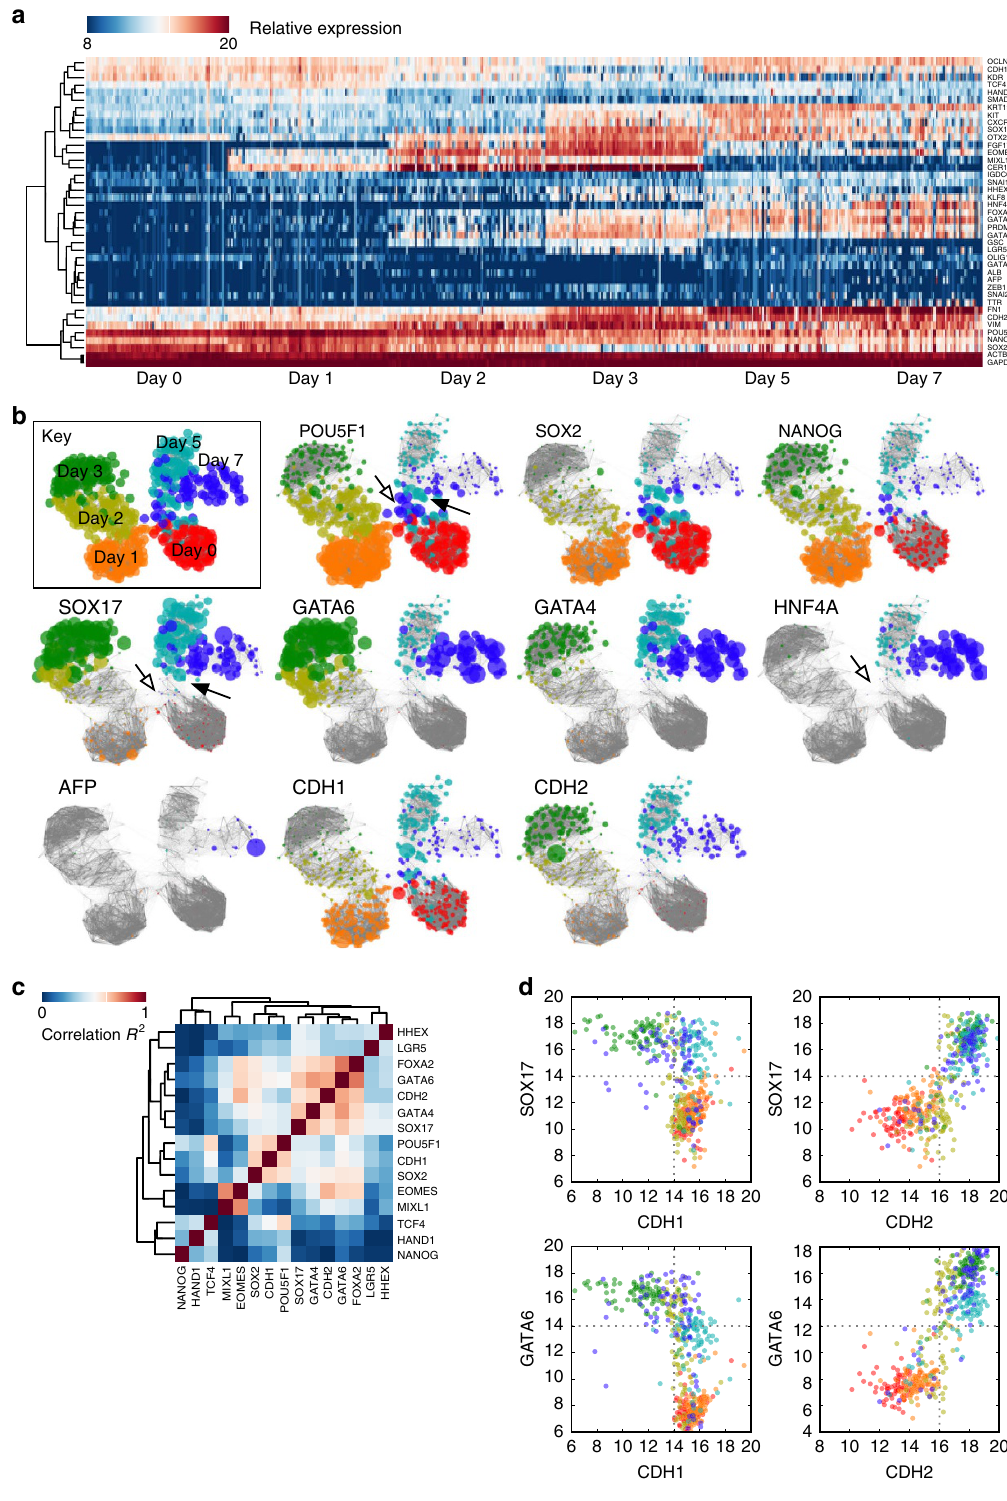
Figure 3 | Single cell qPCR analysis reveals a synchronous EMTduring the differentiation of hESCs to DE. ( a ) Heatmap of the expressions of selected genes. A complete list of genes used in the study can be found at Supplementary Table 3. ( b ) Relational network plots. Different colours indicate specific days of treatment, node sizes are 2 (relative expression) . Open arrows indicate a population of day 5/7 hESC-like cells expressing POU5F1 , SOX2 , NANOG . Closed arrows indicate a population of cells simultaneously expressing the pluripotent marker genes POU5F1 , SOX2 , NANOG and the DE markers SOX17 , GATA4 and GATA6 . ( c ) Correlation of gene expression for the indicated genes for days 0 through 3. ( d ) Scatter plots of single cell gene expression for SOX17 and GATA6 versus the epithelial marker gene CDH1 and the mesenchymal marker gene CDH2 . Colours are the same as in b